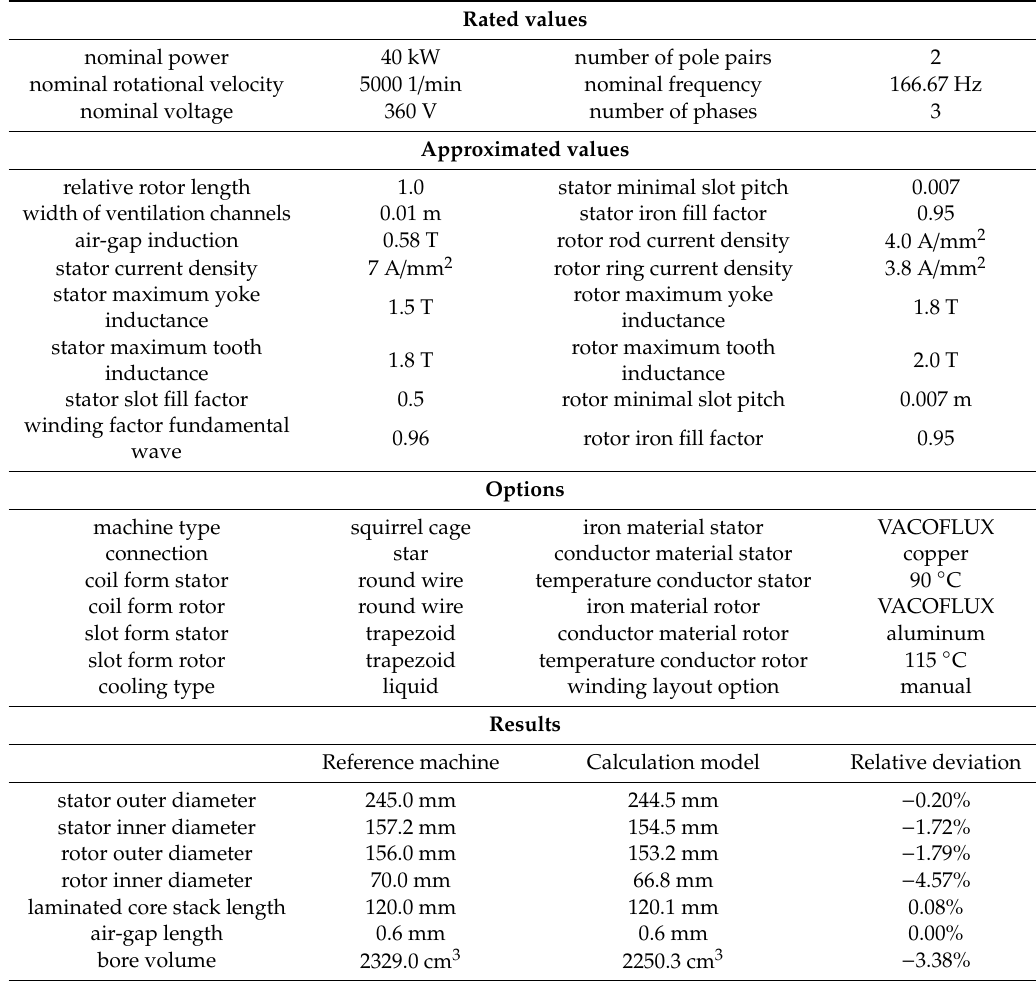
Table 4. Input parameters for validation of main dimensions—Audi